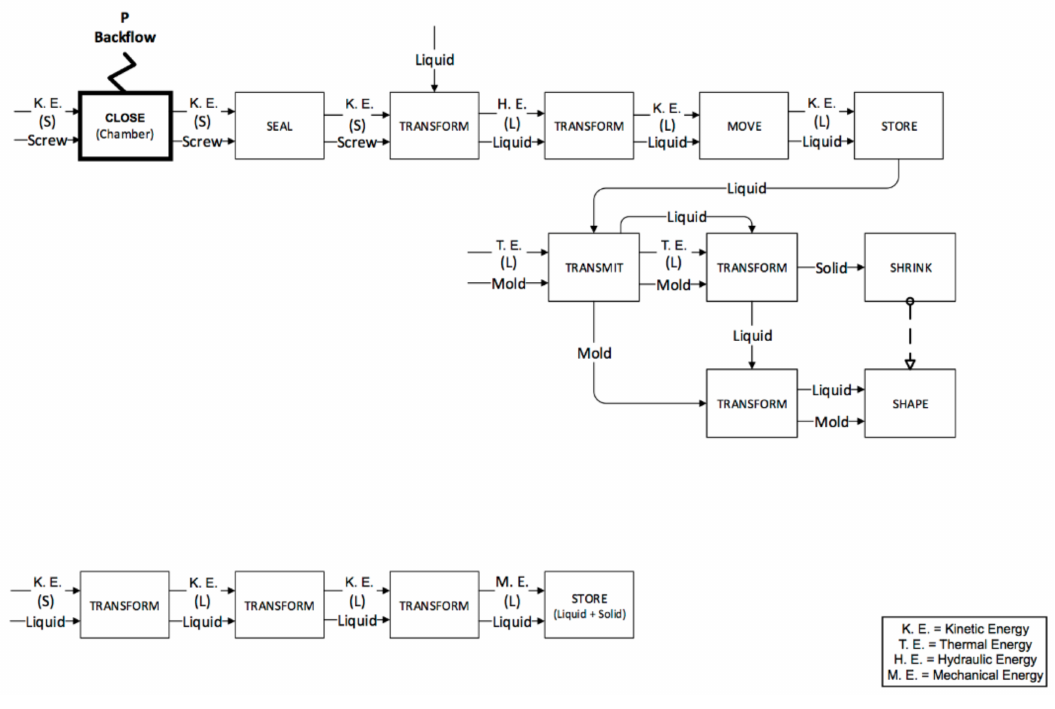
Figure 10. Injection phase for the IM machine.